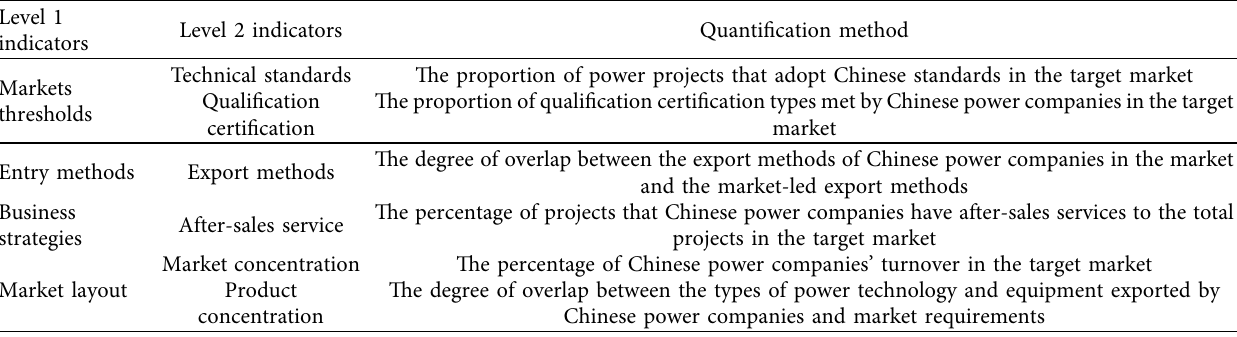
Table 1: Matching indicators and quantification